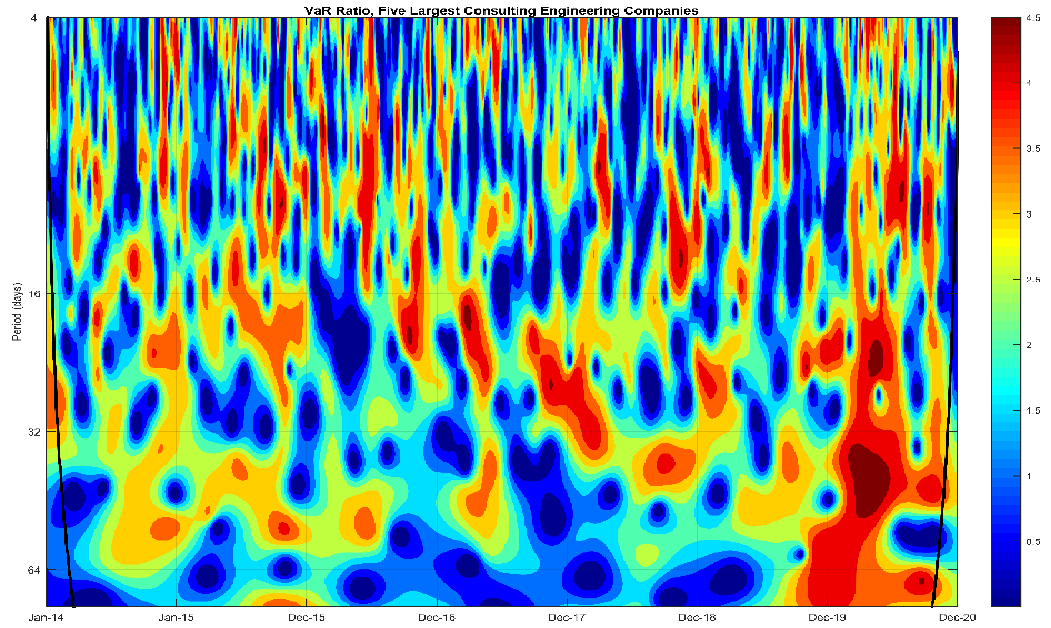
Figure 4. Ratio between the value at risk (VaR) of the five largest consulting engineering companies portfolio with and without co-movement. Notes: Data from 9 January 2014 to 9 December 2020. Source: Investing.com. Accessed on 11 De-